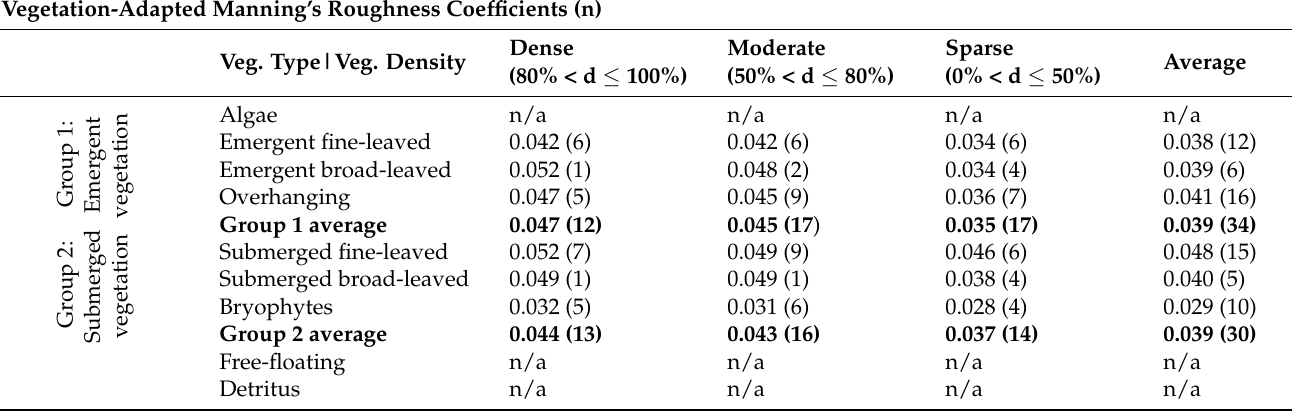
Table 1. Manning’s roughness coefficients (n) for emergent and submerged vegetation types in varying densities. Numbers in parentheses indicate the number of samples of each vegetation type.